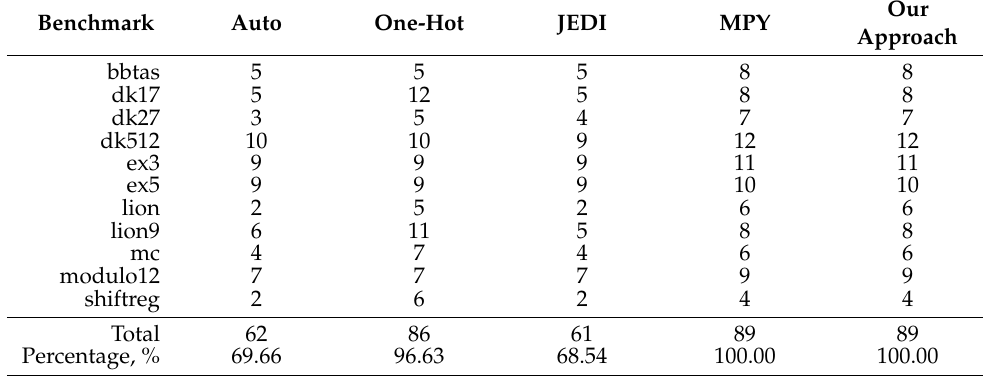
Table 10. Experimental results (numbers of LUTs for BMs from BM1).